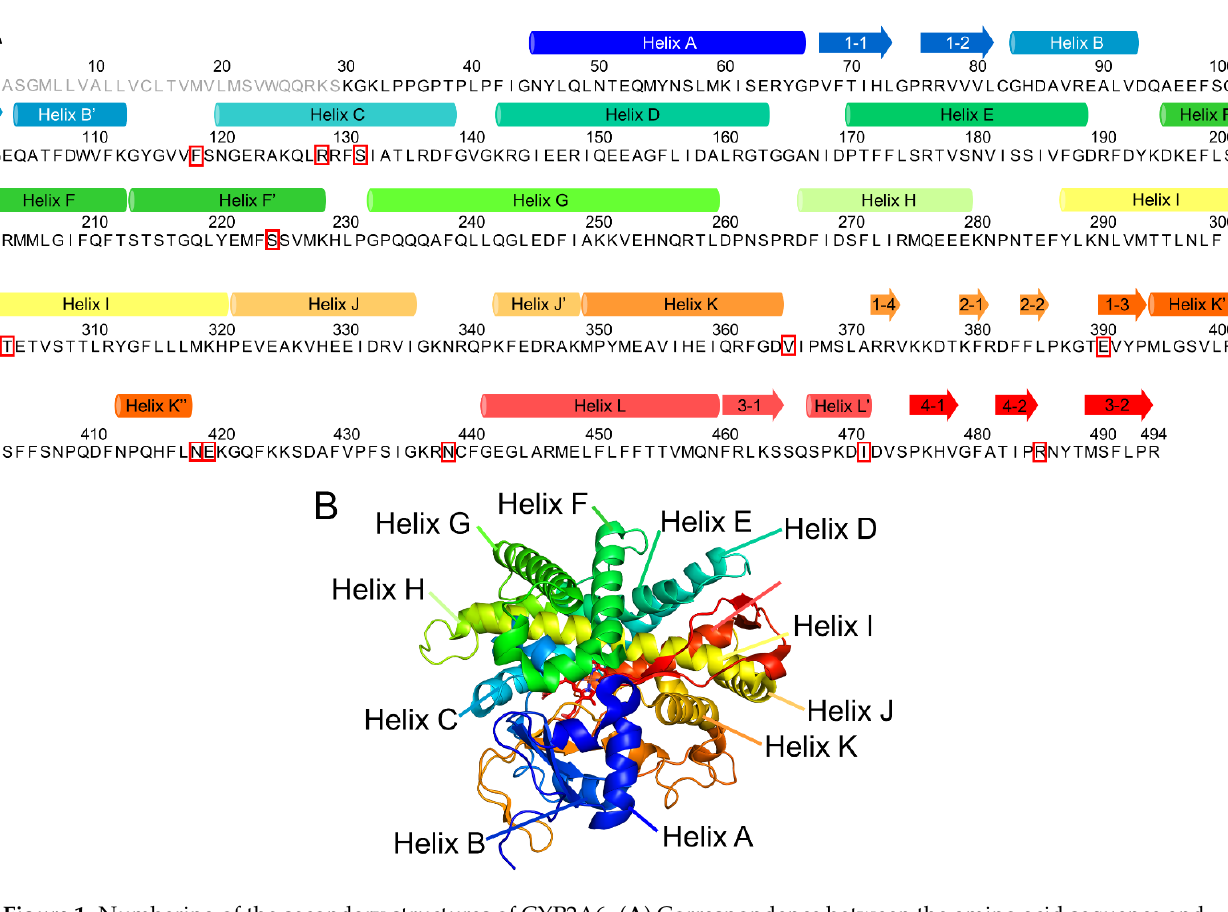
Figure 1. Numbering of the secondary structures of CYP2A6. ( A ) Correspondence between the amino acid sequence and secondary structures. The circular column and arrow indicate helix and β-strand formation regions, respectively. The gray letters of the amino acid sequence are the disordered region in the crystal structure. The mutation sites relevant to 10 variants investigated in this study are shown in red squares. ( B ) Correspondence between the three-dimensional structure and secondary structures.